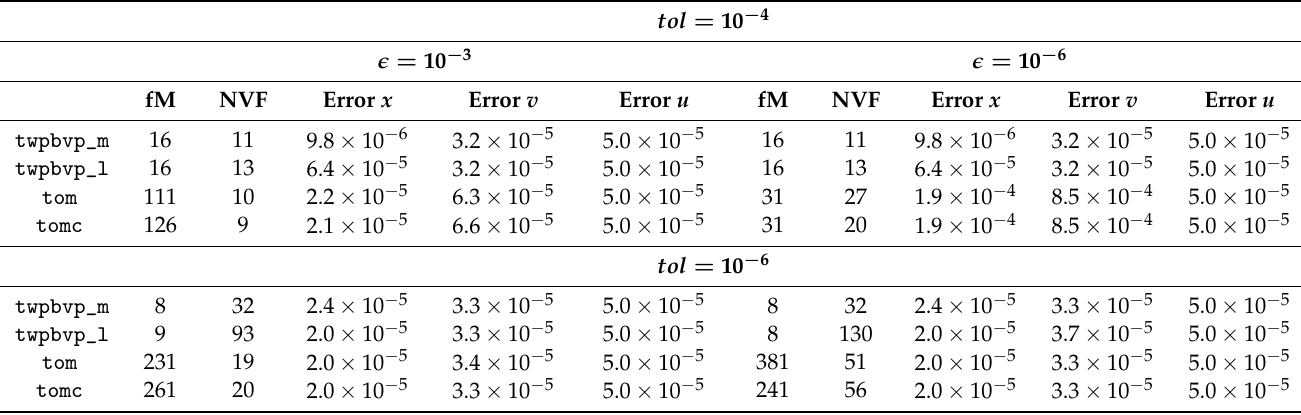
Table 12. Bang-Bang optimal control problem-solving (8) using a piecewise quadratic penalty function with σ = 10 − 4 : final mesh (fM), total number of vectorized function evaluation (NVF) and mixed errors for x , v , u .